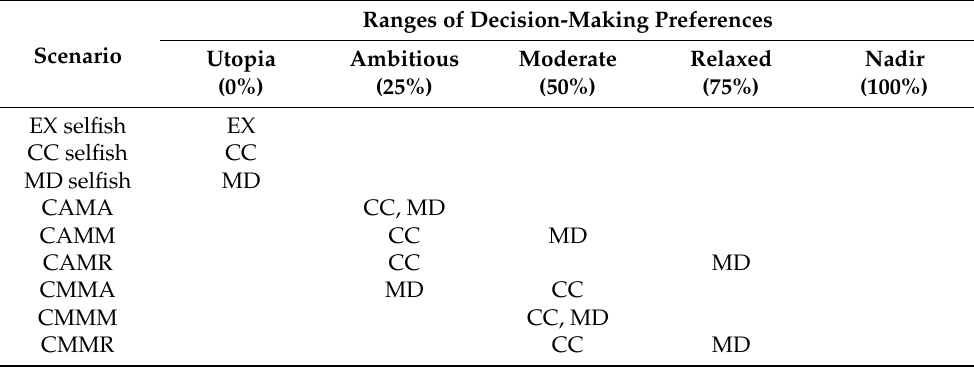
Table 1. Definition of the scenarios with different decision-making preferences.